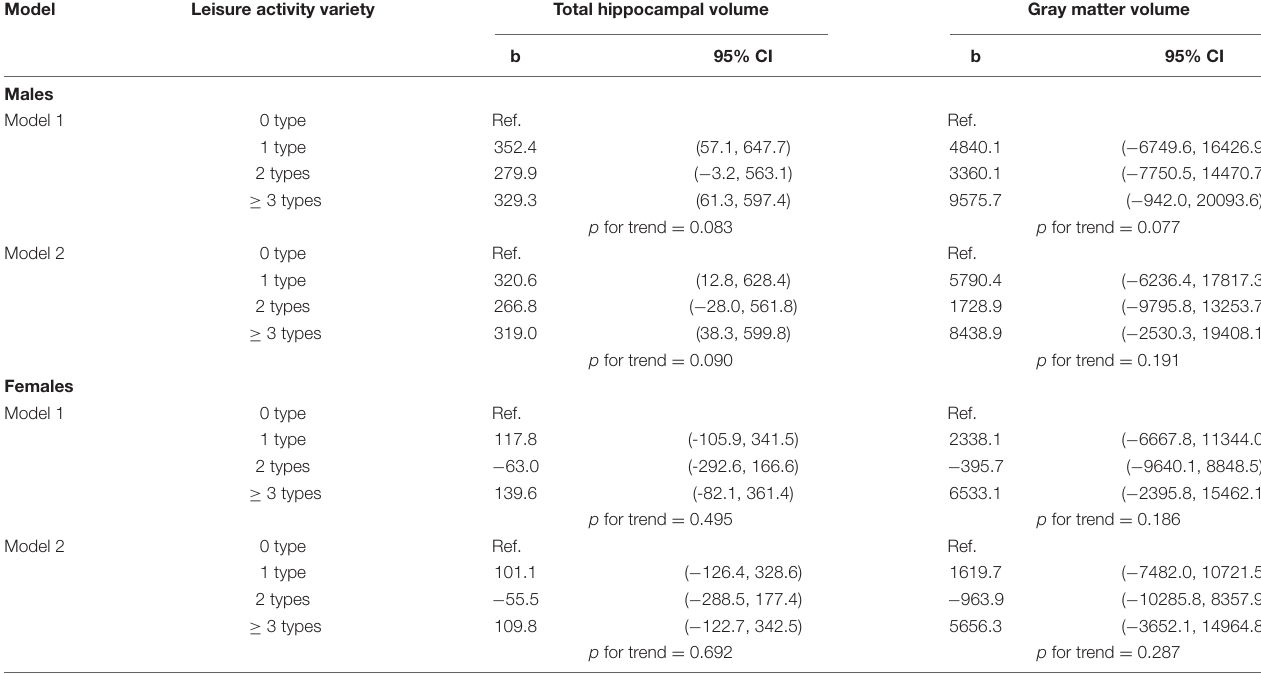
TABLE 4 | Association between leisure activity variety and brain volume by